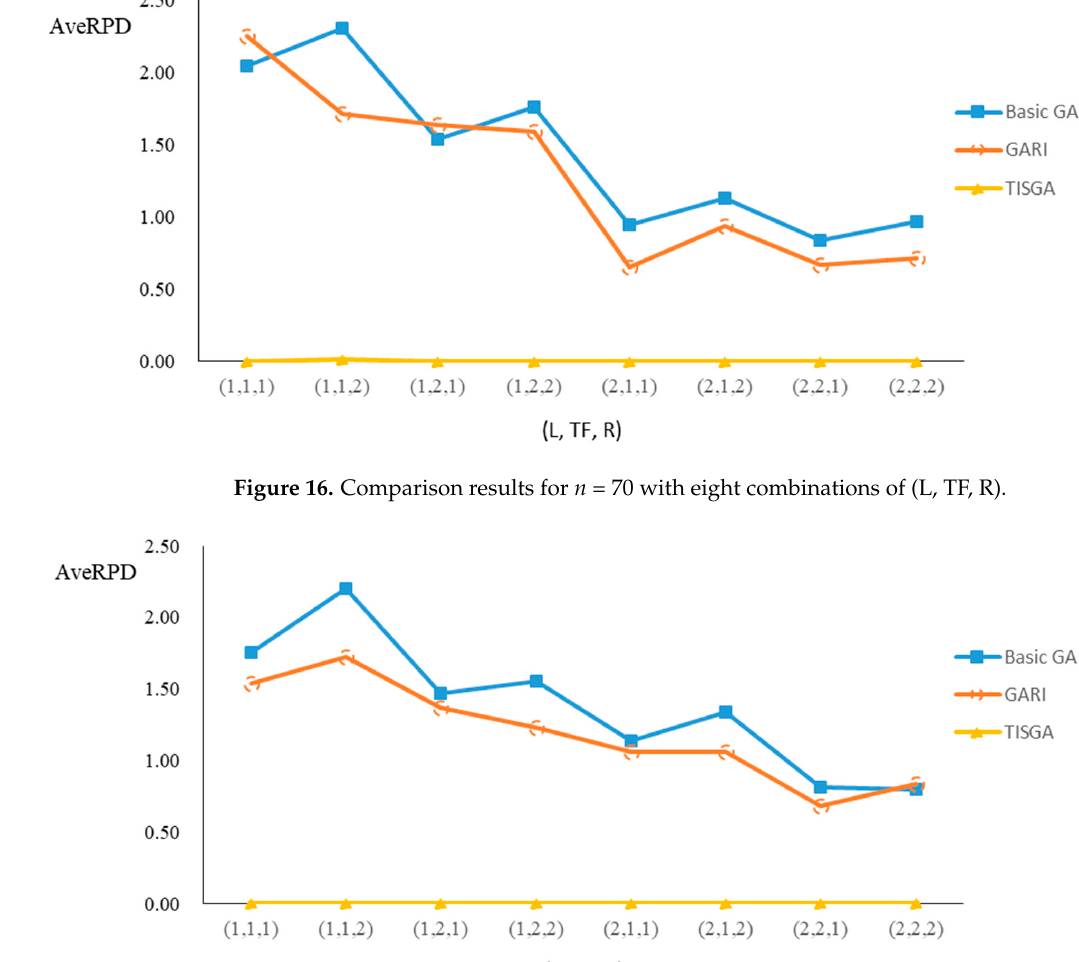
Figure 17. Comparison results for n = 80 with eight combinations of (L, TF, R).